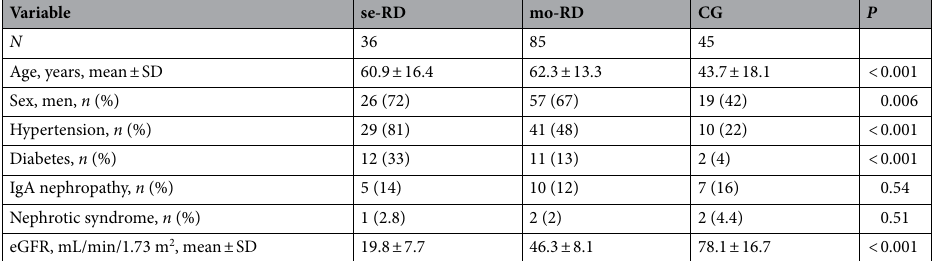
Table 1. The demographic and clinical characteristics of the study population. Unless otherwise indicated, data are represented as the number (%) of patients. se-RD severe renal dysfunction (estimated